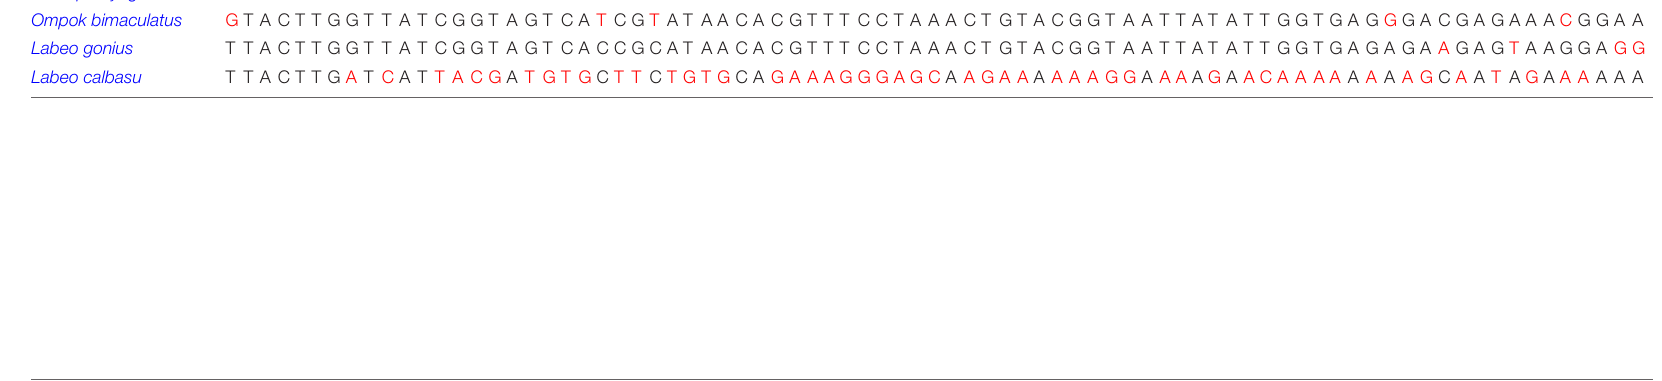
TABLE 6 | Identification of marine fish species based on single nucleotide polymorphism data analysis. Pampas